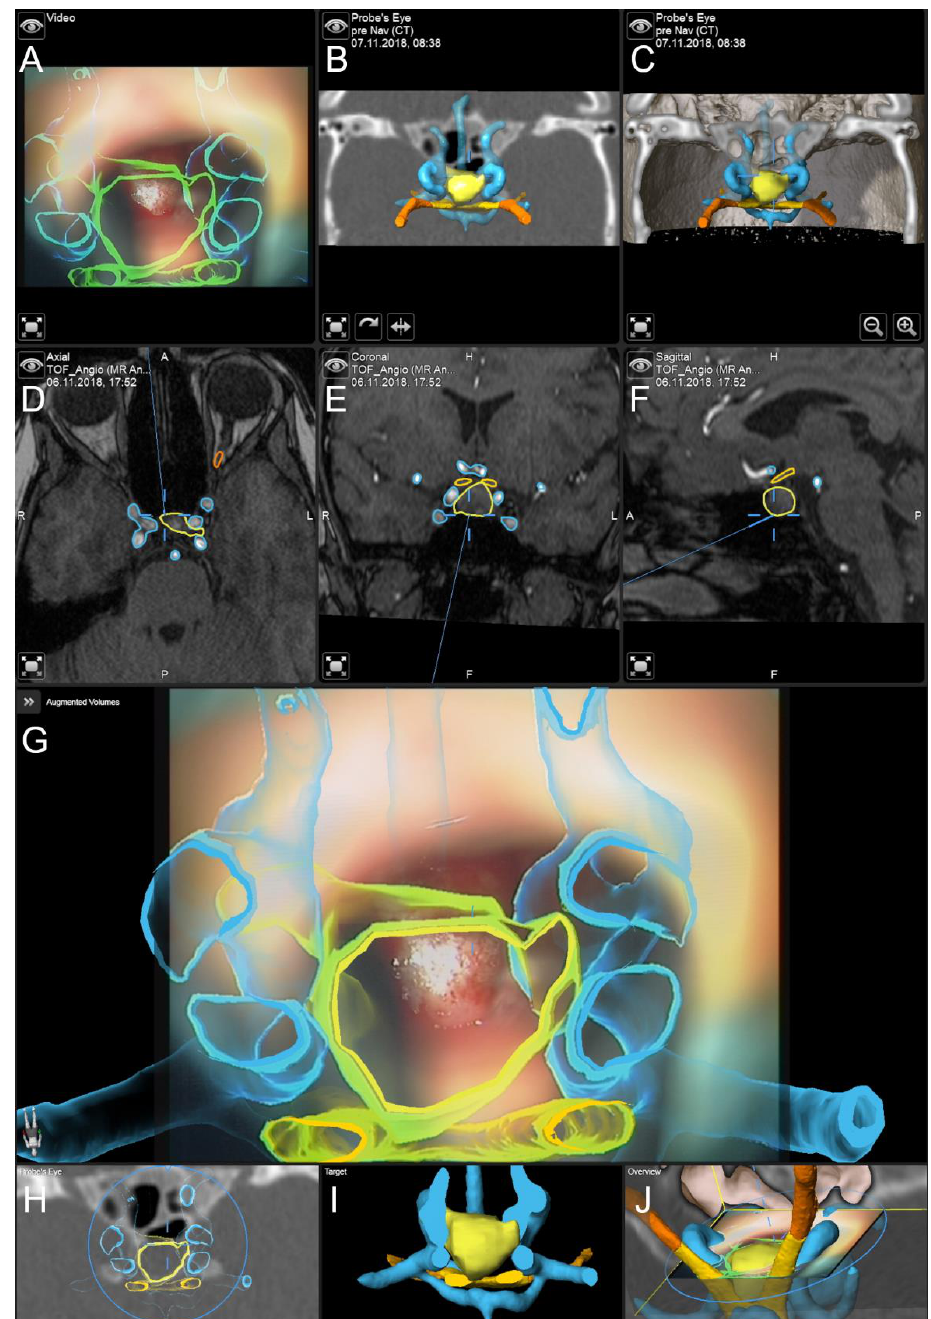
Figure 3. Navigation and AR support in the case of a 37-year-old female patient with a gonadotropic pituitary adenoma. Pre-segmented objects include the lesion (yellow), the carotid arteries (blue), the chiasm (yellow), and the optic nerves (orange). ( A ) Microscope video with 3D visualization of segmented objects using the head-up display. ( B ) The 2D and ( C ) 3D probe’s eye view of intraoperative CT data with 3D visualization of segmented objects. ( D ) Axial, ( E ) coronal, and ( F ) sagittal view (standard navigation) of preoperative time-of-flight MR angiography data with focus on the sella floor. ( G ) AR visualization superimposed on the microscope video with a 3D representation of segmented structures. ( H ) Corresponding probe’s eye view, ( I ) target view (visualizing the lesion (selected as target) in an uncut manner while only parts of the remaining objects distal to the focus plane are displayed), and ( J ) 2D overview depicting the video plane in relation to the 3D visualization of all objects.